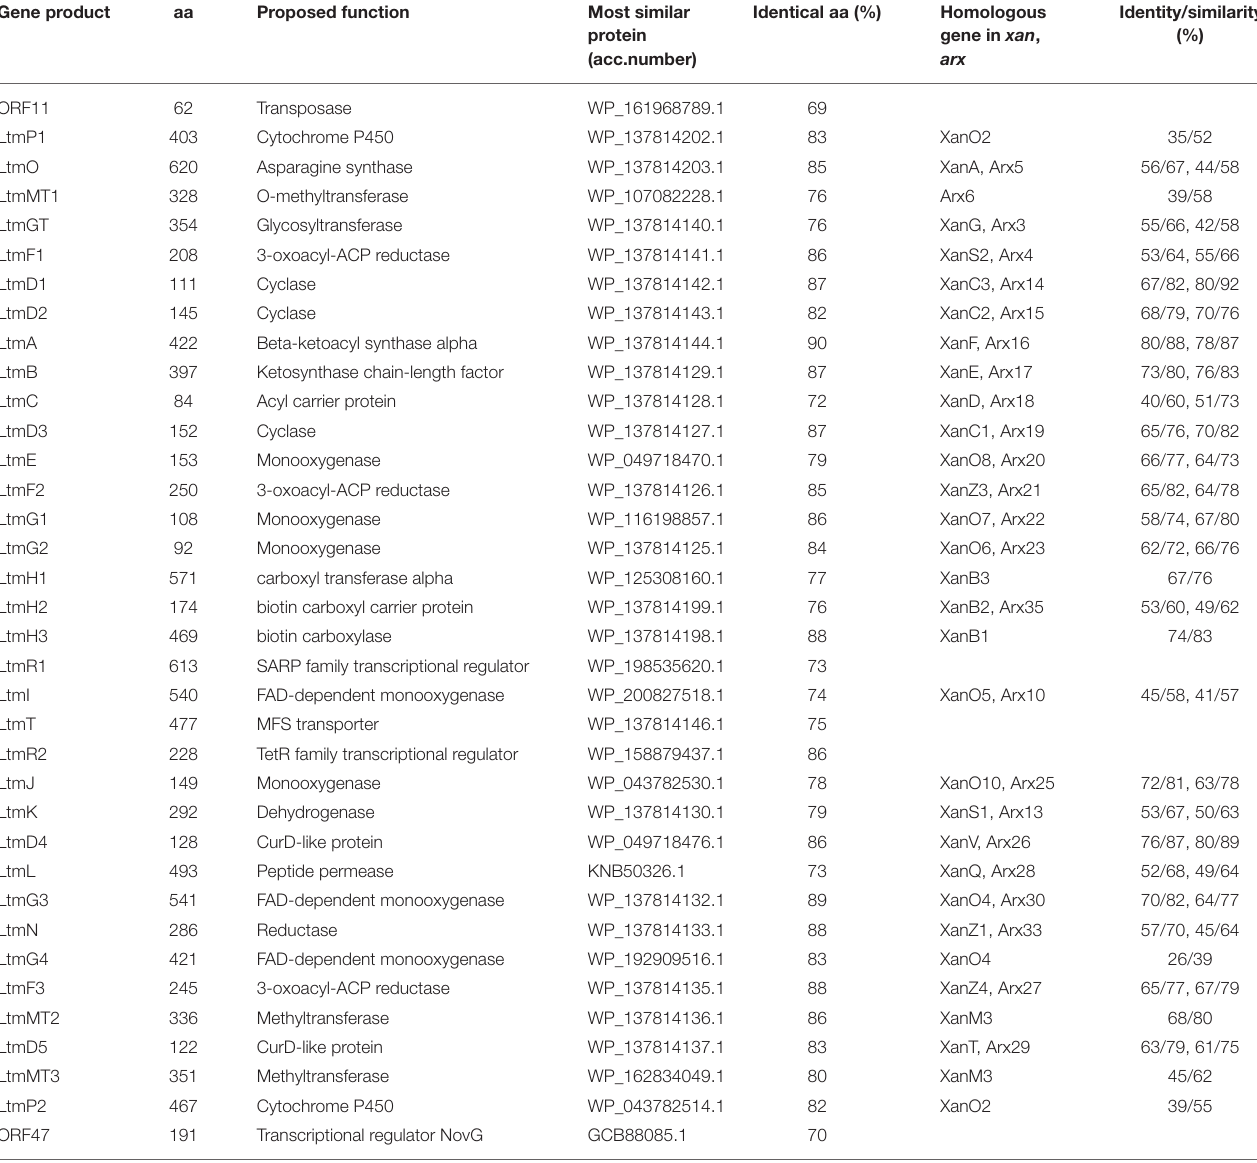
TABLE 1 | Deduced functions of genes in the lanthomicin biosynthesis gene cluster and protein homologs annotation. Gene